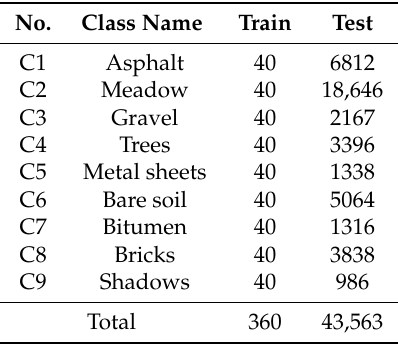
Figure 5. Reflective Optics System Imaging Spectrometer (ROSIS) University of Pavia dataset. ( a ) RGB composite image. ( b ) Ground reference map. Table 3. The ground reference classes in the ROSIS University of Pavia dataset and the number of training and test pixels used in